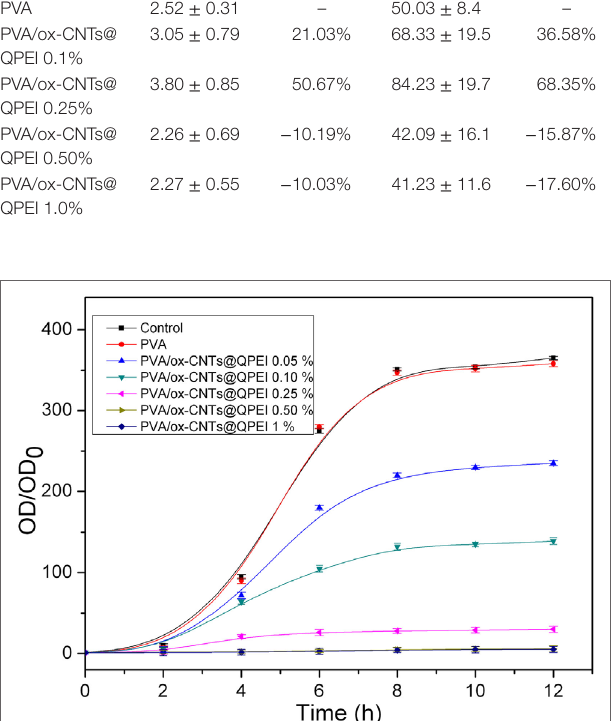
FigUre 11 | Growth curves of Gram­negative E. coli bacteria incubated in the presence of PVA/ox­CNTs@QPEI nanocomposites. The control was bacteria treated with distilled water.